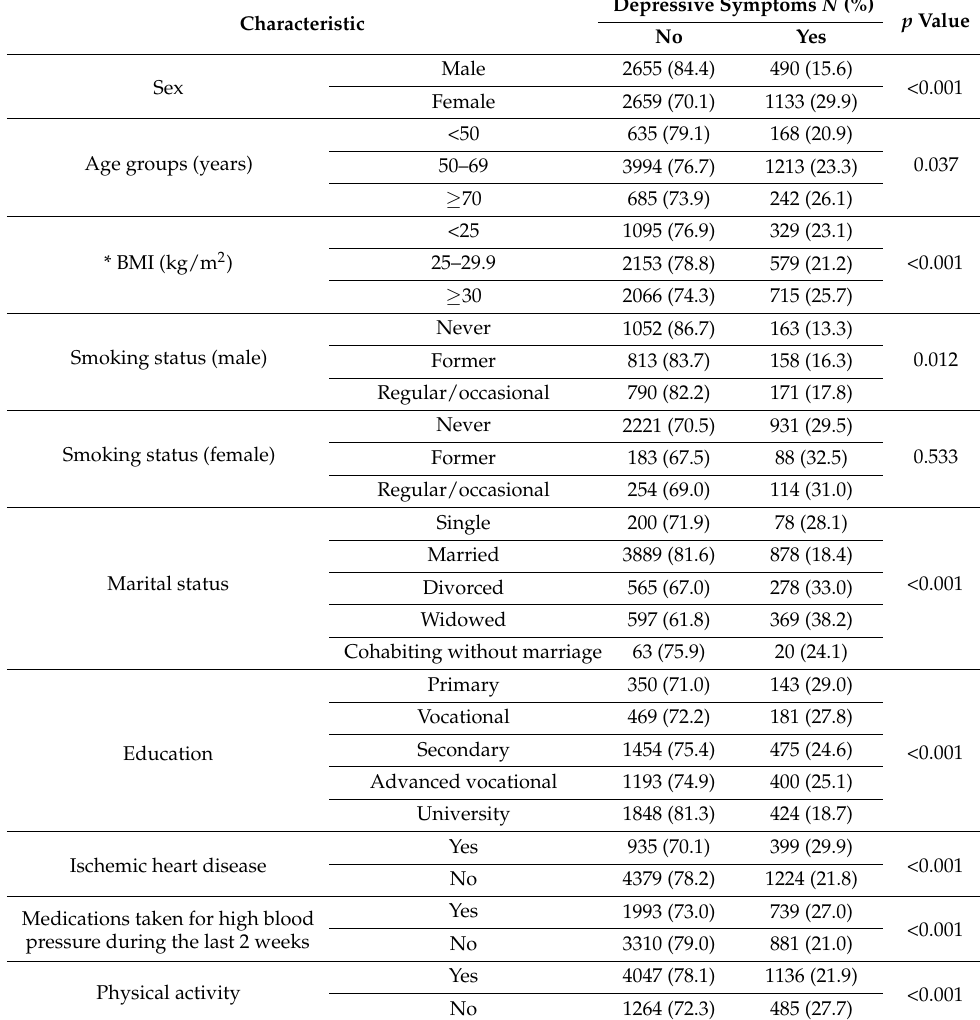
Table 1. Distribution of participants with depressive symptoms according to risk